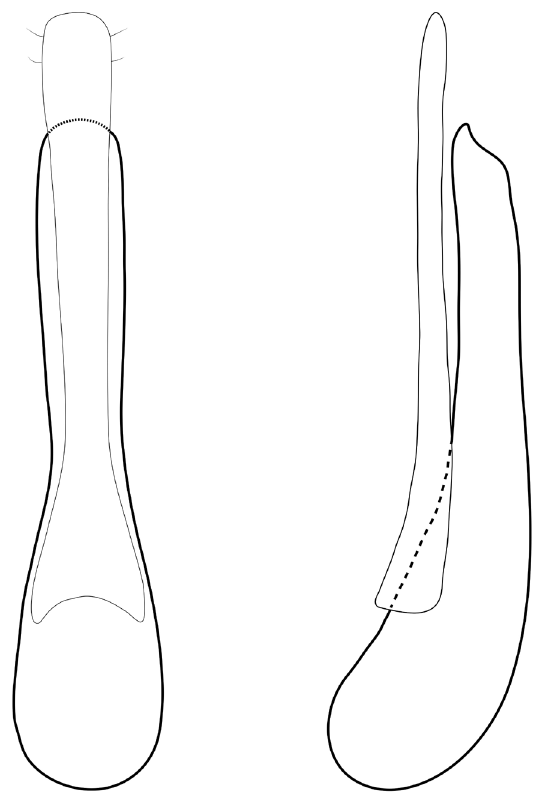
Figure 7. Aedeagus of Quediopsis howensis Jenkins Shaw & Solodovnikov, sp. n. Parameral view (left), lateral view (right). P = parameres, ML = median